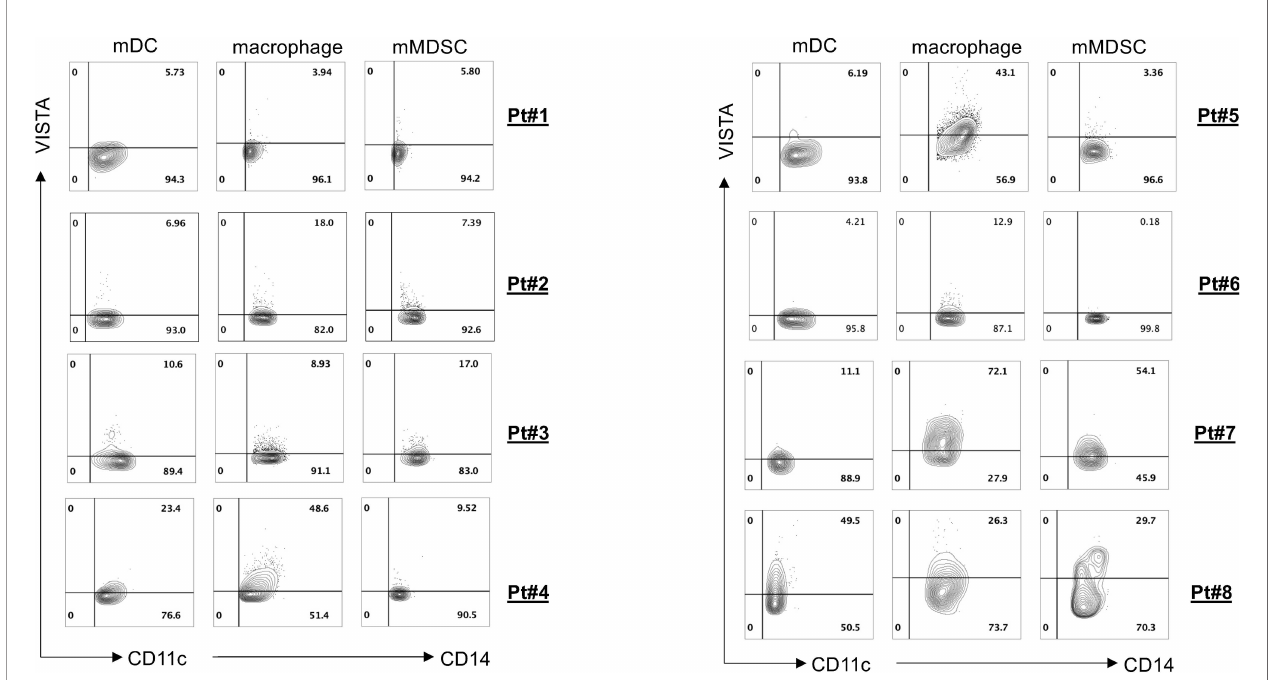
FIGURE 2 | VISTA expression on various myeloid cell subsets. Tumor-in fi ltrating leukocytes were isolated from fresh tumors of 8 clear cell renal cell carcinoma (ccRCC) patients and then stained with different antibodies against the cell surface. Fluorescence-activated cell sorting (FACS) plot showed VISTA expression on different myeloid cell subsets.